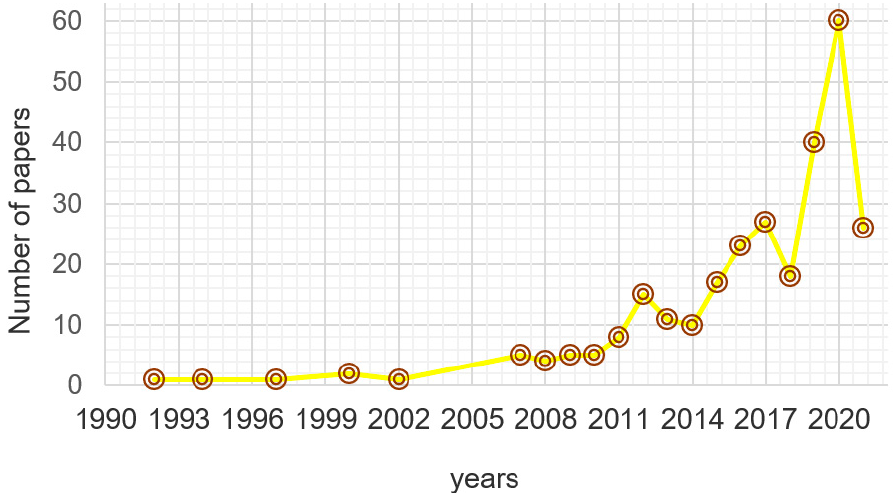
Figure 2. Paper publications per year.